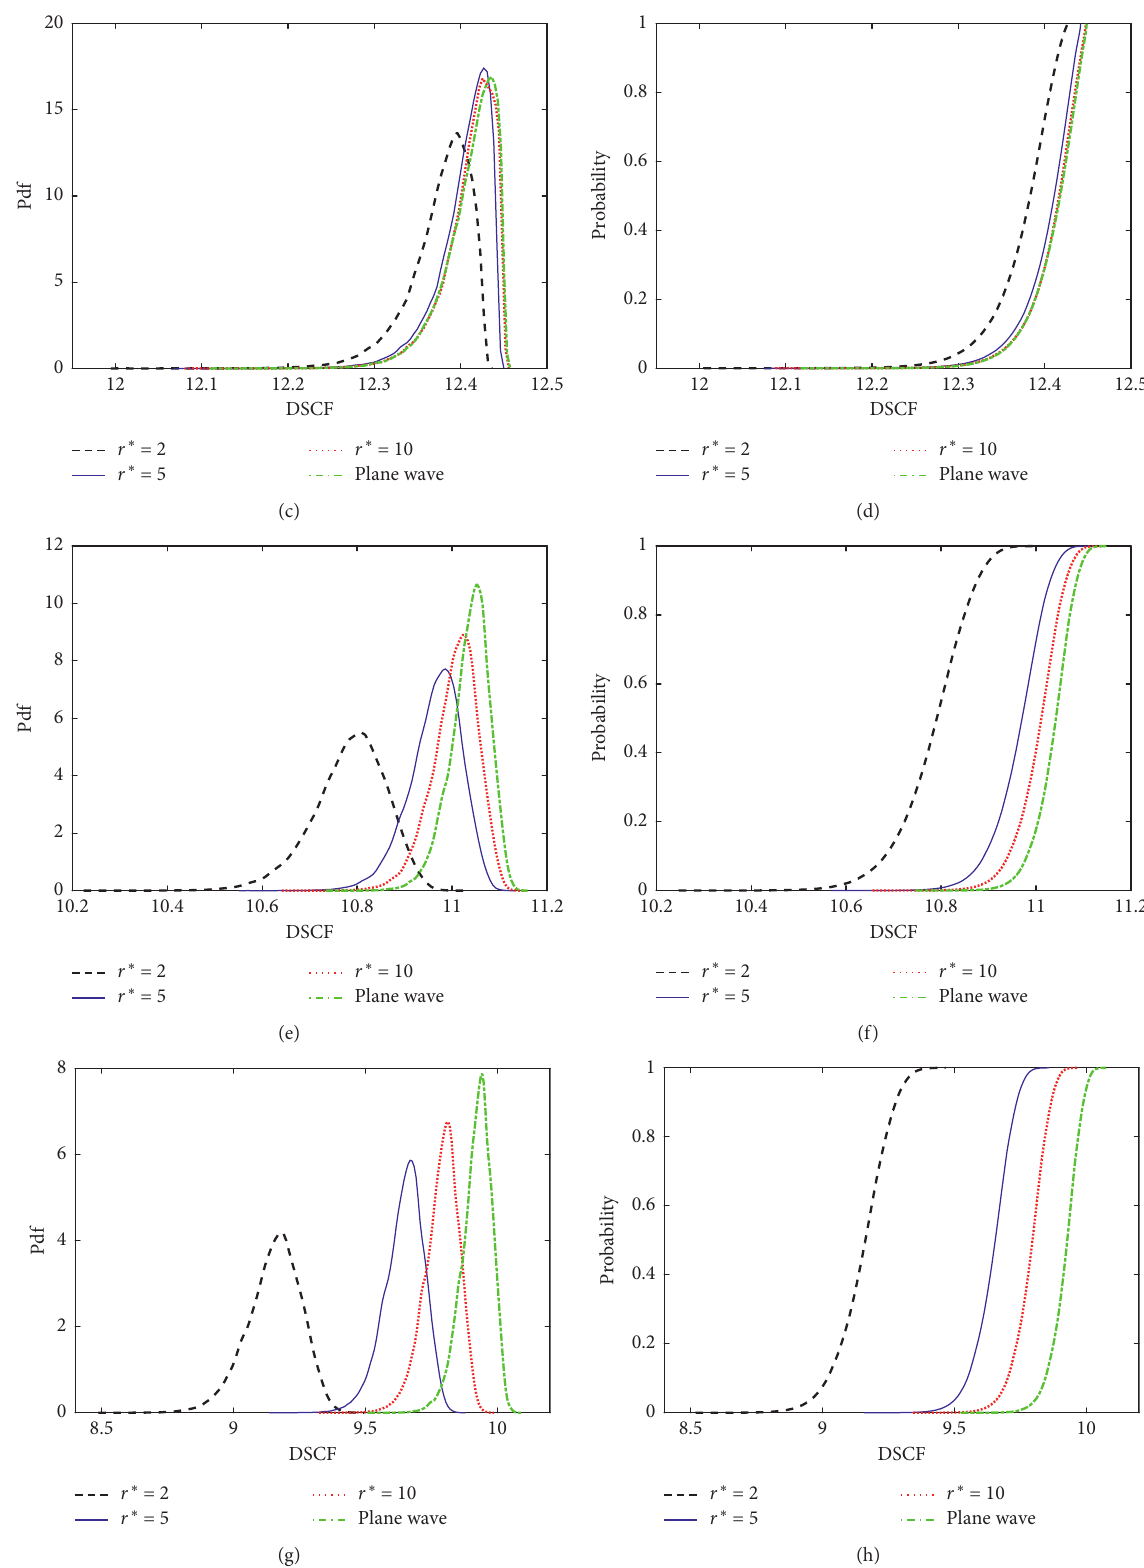
Figure 4: PDF curves (left) and CDF curves (right) of DSCF when δ f � 50Hz; (e) PDF f � 100Hz; (f) CDF f � 100Hz; (g) PDF f � 200Hz; (h) CDF f �